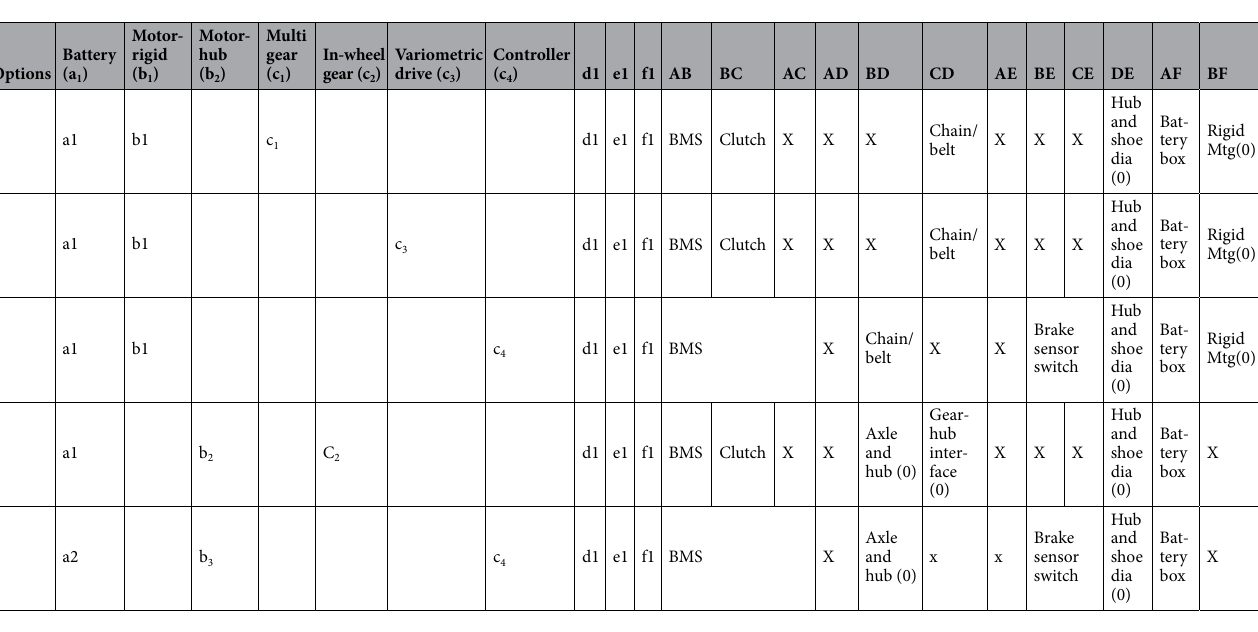
Table 19. Listing the feasible